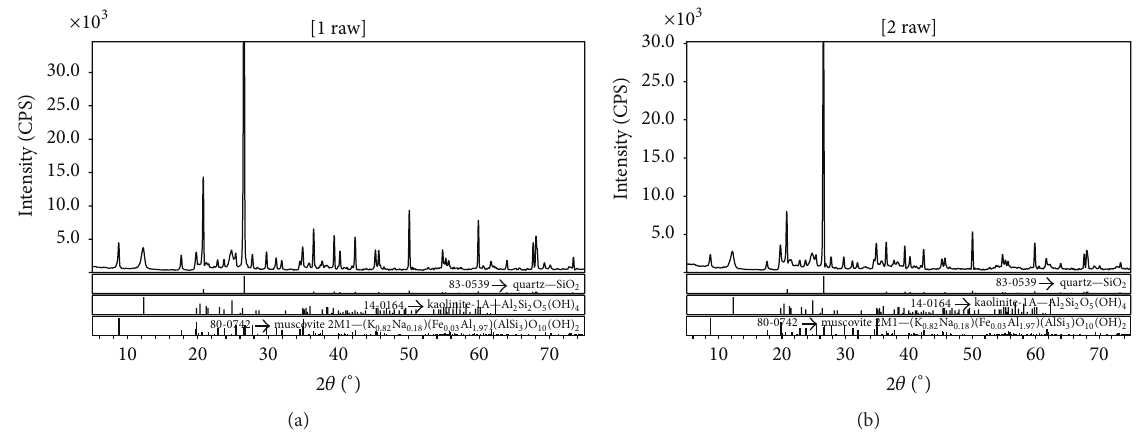
Figure 1: X-ray diffraction figures of low-grade metamorphic slate: (a) Specimen 1; (b) Specimen 2.